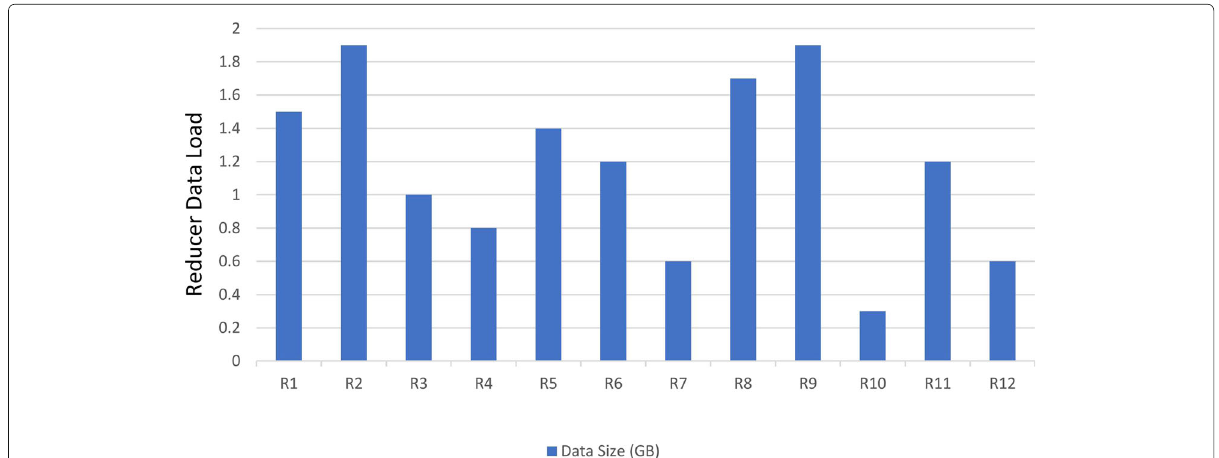
Fig. 2 Variation in reducers data